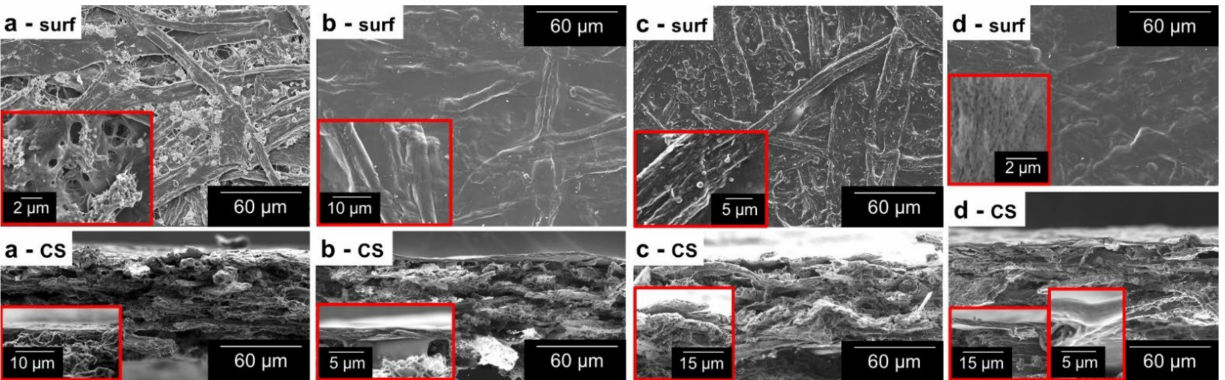
Figure 1. Micrographs of the surface ( surf ) and the cross-section ( CS ) of uncoated paper ( a ), CNF2% ( b ), Hydro 3 ( c ), and Multi 2 ( d ). Inset images display magnified sections of the same